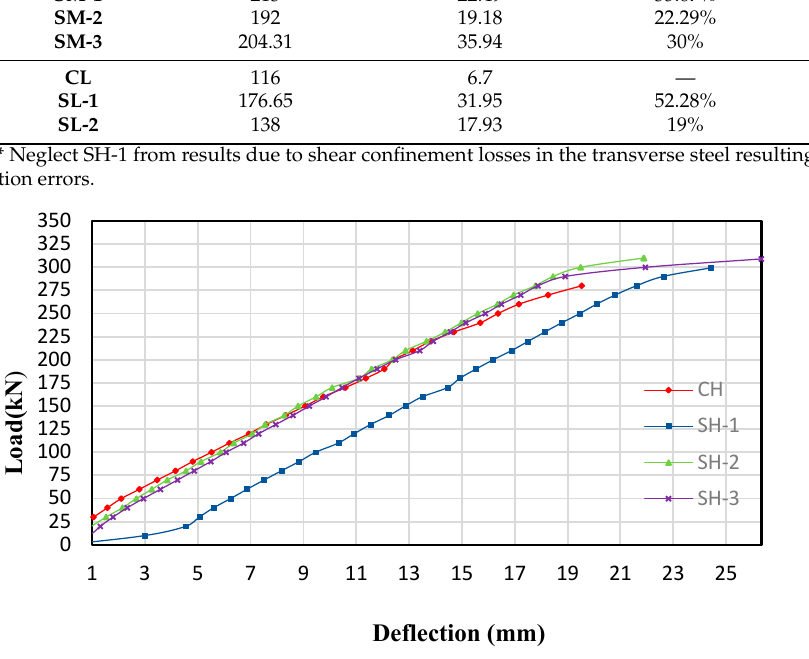
Figure 8. Load–deflection curve for beams of group L. 3.2. Failure Modes In this experimental program, different modes of failure were observed, namely, pure-flexural failure, concrete crushing, intermediate de-bonding and end-cover- separation resulting from NSM-CFRPs strips. For the unstrengthened beams, as shown in Figure 9a–c, a pure flexural failure was the dominant failure mode accompanying crushing at the concrete’s top fiber for beams CH and CM, while it was a pure flexure failure in beam (CL). Regarding the beams strengthened with two CFRPs strips along the entire beam span (SM-1 and SL-1), (SM-1) failed by pure flexure with an intermediate epoxy-de-bonding as shown in Figure 9d, while in Figure 9e, the failure mode for (SL-1) was pure-flexure only. Additionally, for specimens SH-1, it is worth mentioning that during NSM application, specifically while the grooves were cut and due to insufficient concrete cover in the bottom face of the beam, the stirrups legs were cut from both grooves sides in order to get enough groove size for the strips. This led to confinement losses in the transverse steel. Therefore, the shear capacity of the beam become low, and the failure mode for specimen’s SH-1 was a shear failure (Figure 9f). This specimen is excluded from the discussion of the results. As for the strengthened beams with two CFRPs strips within the maximum-moment zone (SH-2, SM2, and SL-2), Figure 9g,h shows that the dominant failure mode was pure flexure accompanying end-cover-separation for both (SM-2) and (SL-2). However, due to its high concrete strength, the specimen (SH-2) did not fail in end-cover separation as the other two specimens; therefore, its failure mode was only a pure flexure failure (Figure